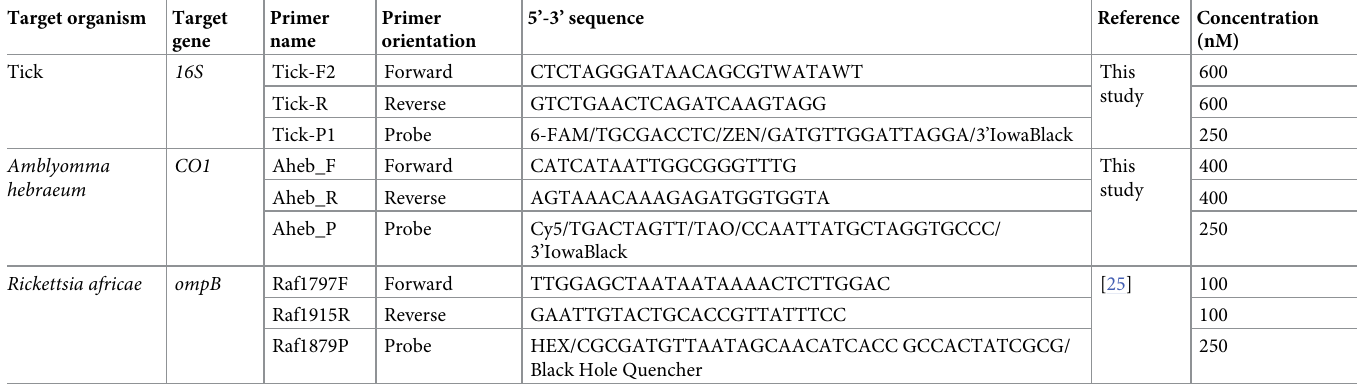
Table 1. The primers, probes, and thermocycling conditions a that were used to detect Rickettsia africae , Rickettsia , and tick DNA in a novel multiplex qPCR assay for this study. Target